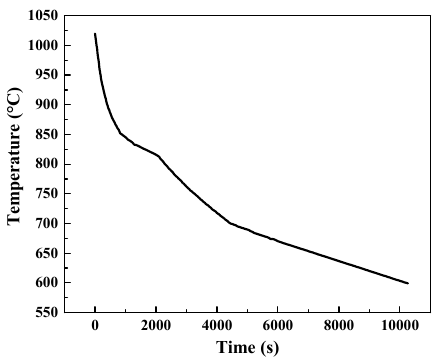
Figure 12. The variation of temperature with time during furnace cooling which is monitored by temperature thermocouple.